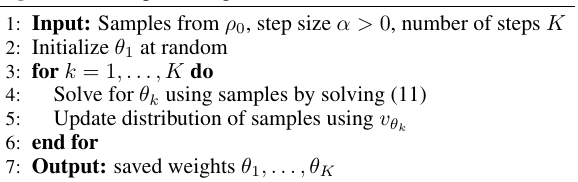
Algorithm 1 Proposed